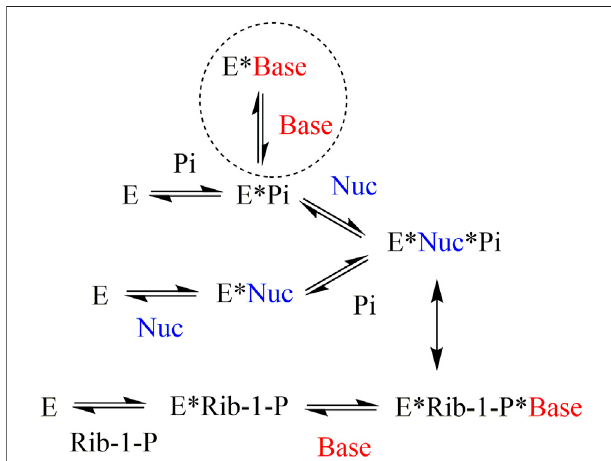
FIGURE 4 | Mechanism of substrate binding in the active site of purine nucleoside phosphorylase from bacterial sources (Jensen, 1976). E –